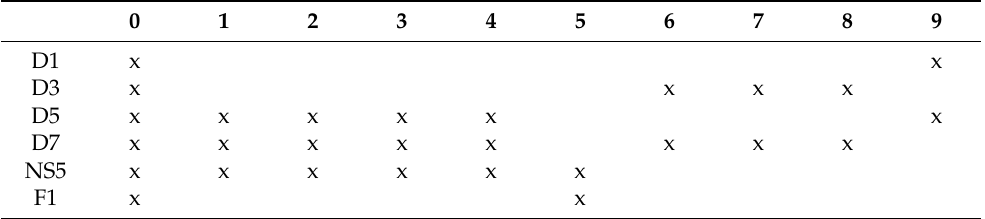
Table 6. Brane set-up underlying the geometry in (32) and (33). x 0 is the time direction; x 1 , . . . , x 4 are the coordinates spanned by the CY 2 ; x 5 is the direction associated with the ρ coordinate; ( x 6 , x 7 , x 8 ) are the transverse coordinates realising the SO(3) R-symmetry; and x 9 is the ψ